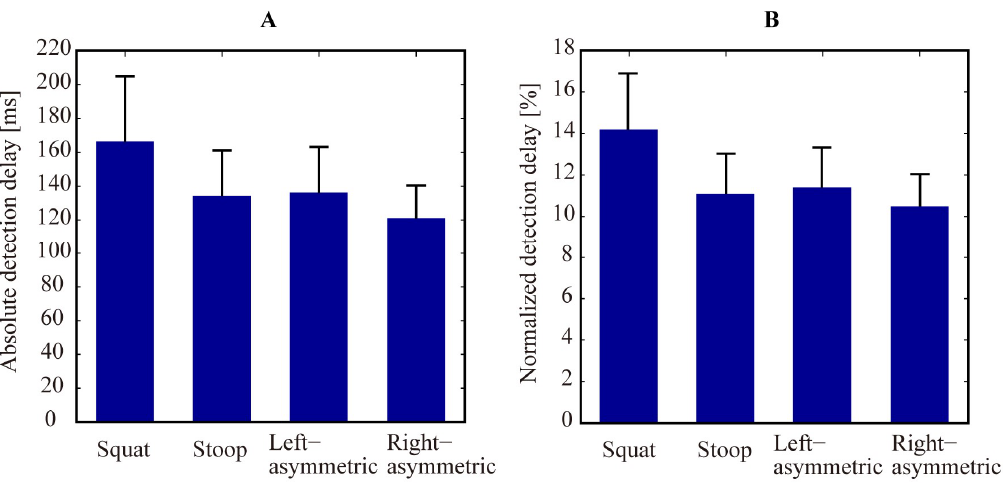
Figure 4. Lifting detection delay of the algorithm. ( A , B ) show absolute and normalized detection delay for four different lifting techniques, respectively. Error bars denote STDs of the delay across 15 subjects.